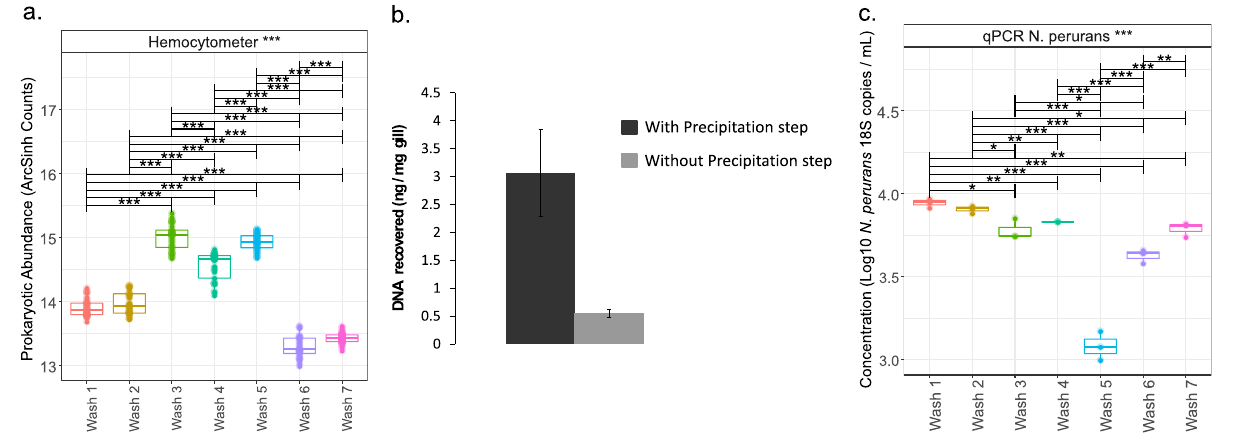
Figure 1. ANOVA of pair-wise comparison of extrinsic metadata considered in this study, and after applying appropriate normalization (where necessary). Lines connect two categories where the differences were significant with *( P < 0.05), **( P < 0.01), or ***( P < 0.001). ( a ) ArcSinh normalisation was used for prokaryote cells from each wash); ( b ) comparison of DNA yield from extractions with and without isopropanol and acetic